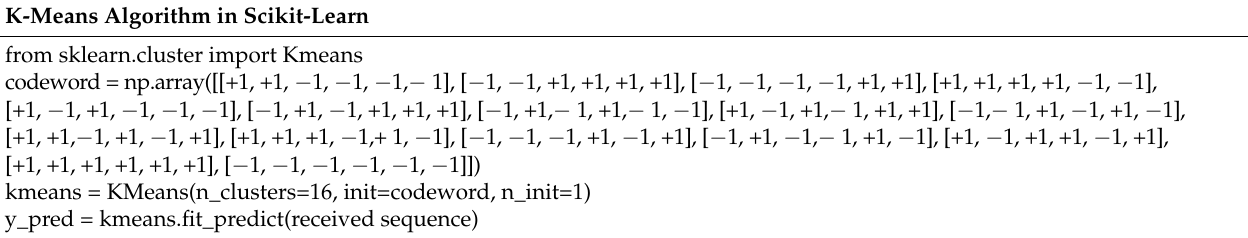
Table 2. K-means algorithm in